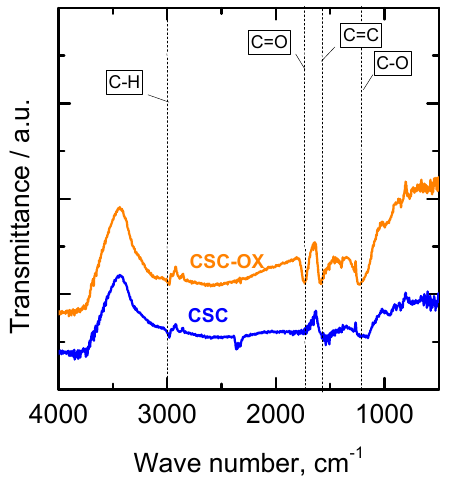
Figure 5. CSC and CSC-OX’s FTIR analysis Figure 4. CSC and CSC-OX’s FTIR analysis Figure 4. CSC and CSC-OX’s FTIR analysis